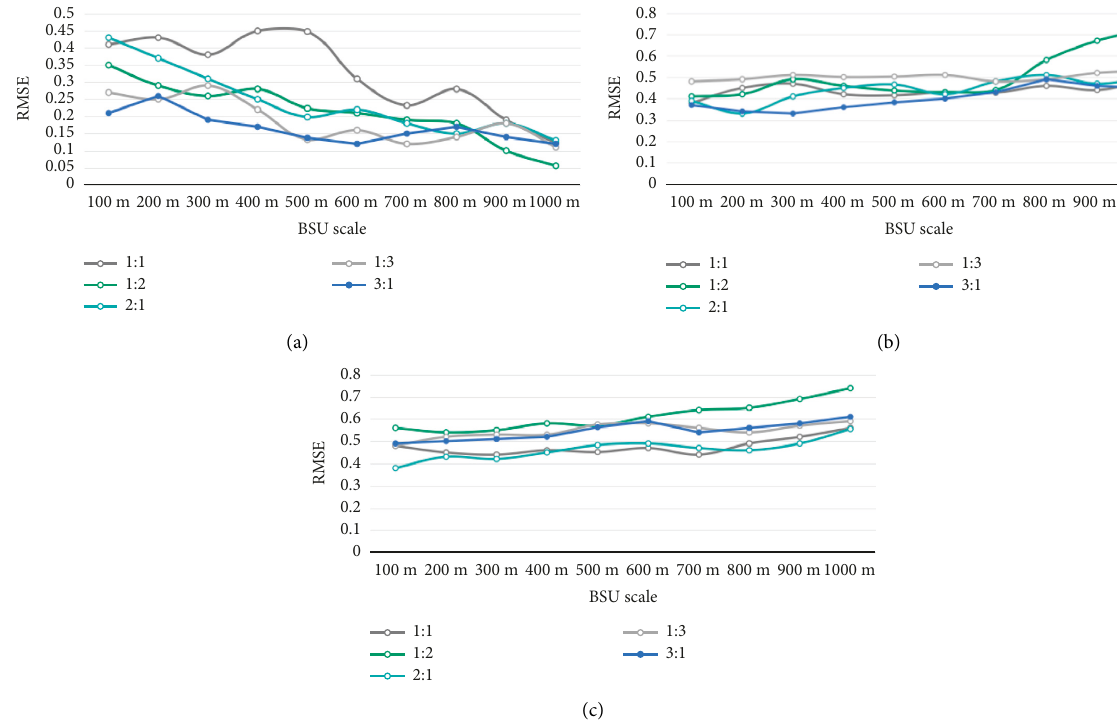
Figure 13: RMSE of GWR model. (a) RMSE of GWR-TE. (b) RMSE of GWR-TS. (c) RMSE of GWR-TC.